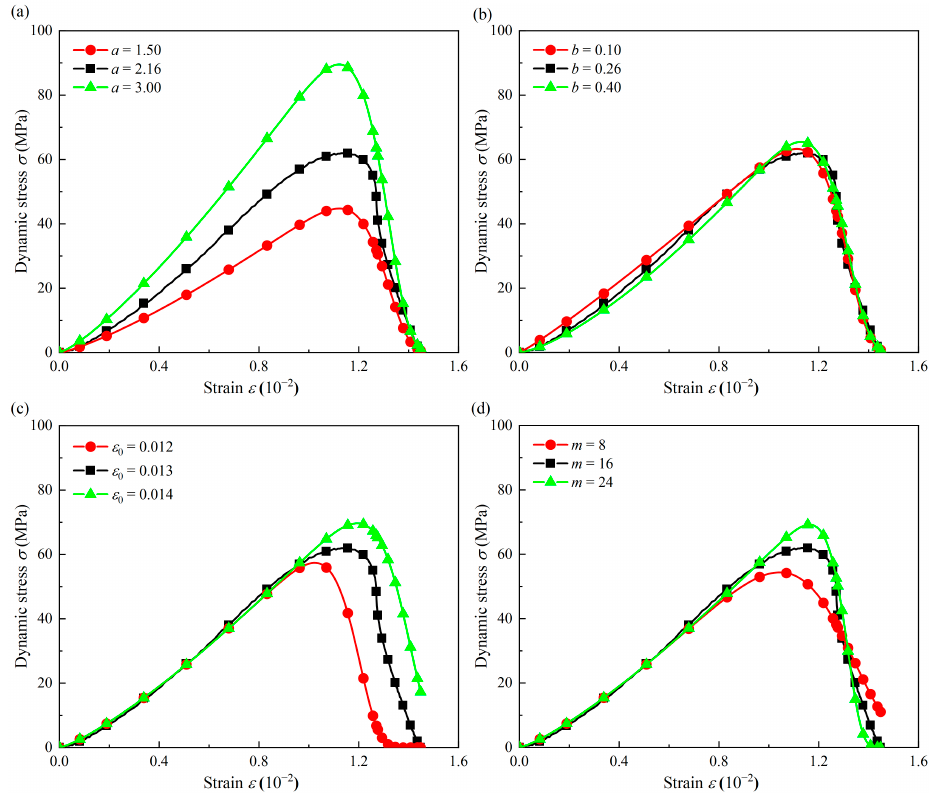
Figure 26. Effects of model parameters on the stress–strain curve: ( a ) parameter a ; ( b ) parameter b ; ( c ) parameter ε 0 ; ( d ) parameter m